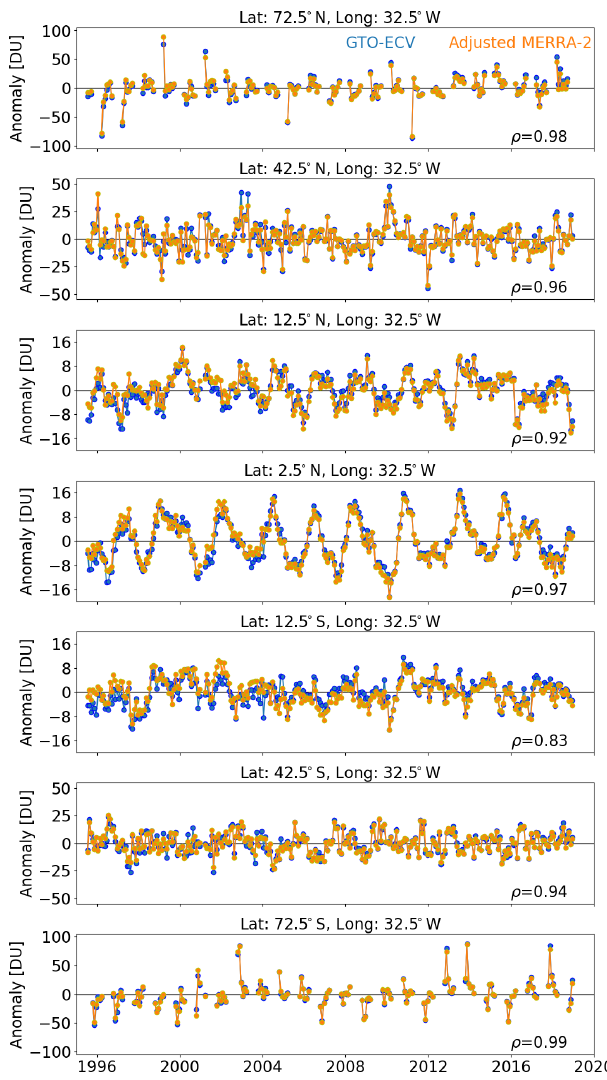
Figure 9. Total ozone anomalies (DU) as a function of time from 1995 to 2018 for GTO-ECV (blue) and adjusted MERRA-2 (or- ange) for seven selected 5 ◦ × 5 ◦ grid cells along 32.5 ◦ W with latitudes from top to bottom: 72.5 ◦ N, 42.5 ◦ N, 12.5 ◦ N, 2.5 ◦ N, 12.5 ◦ S, 42.5 ◦ S, and 72.5 ◦ S. Numbers in the bottom right corner of each panel denote the correlation coefficient ρ between adjusted MERRA-2 and GTO-ECV anomalies.